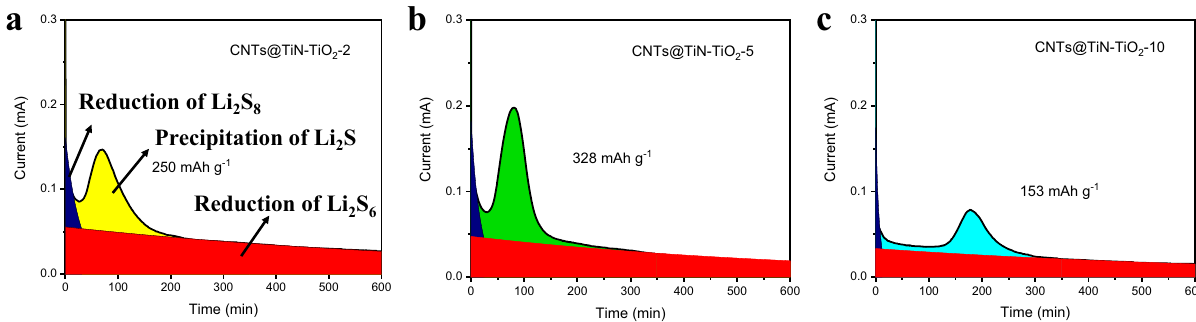
Fig. 4 Li 2 S deposition process under potentiostatic discharge condition. Potentiostatic discharge curves of a CNTs@TiN – TiO 2 -2, b CNTs@TiN – TiO 2 -5, and c CNTs@TiN – TiO 2 -10 at 2.05 V. Source data are provided as a Source Data fi le.